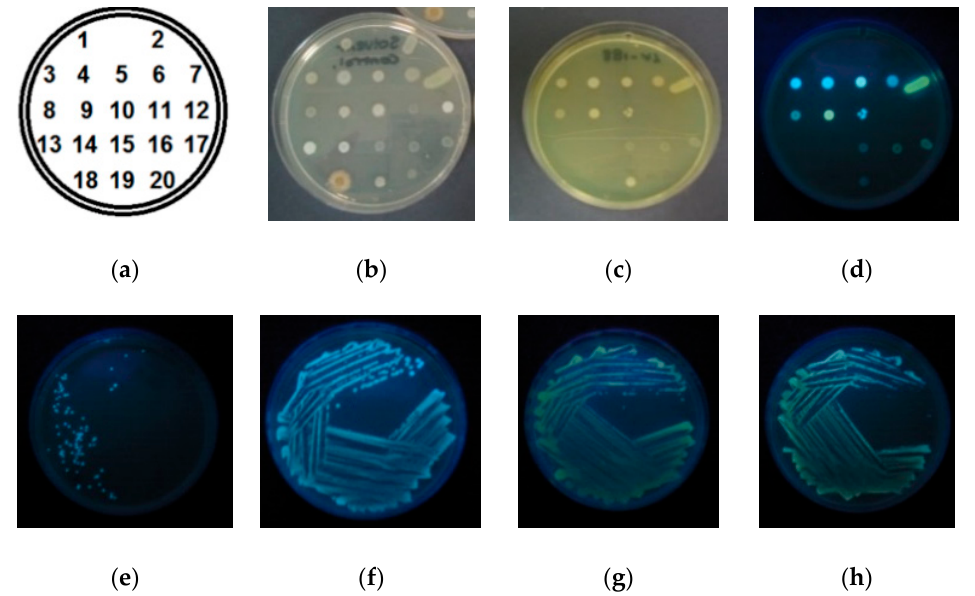
Figure 3. Spotted (top row) and streaked (bottom) inoculation of isolated colonies: ( a ) numbered strains corresponding to Table 2, ( b ) control plate containing no substrate; and plates supplemented with substrate 9 at 100 mg/L ( c ) colonies under natural light, ( d ) under 365 nm UV light source; agar containing 50 mg/mL of substrate 9 , inoculated with isolates of ( e ) A. baumanii , ( f ) E. cloacae , ( g ) P. aeruginosa , and ( h ) B. cepacia .